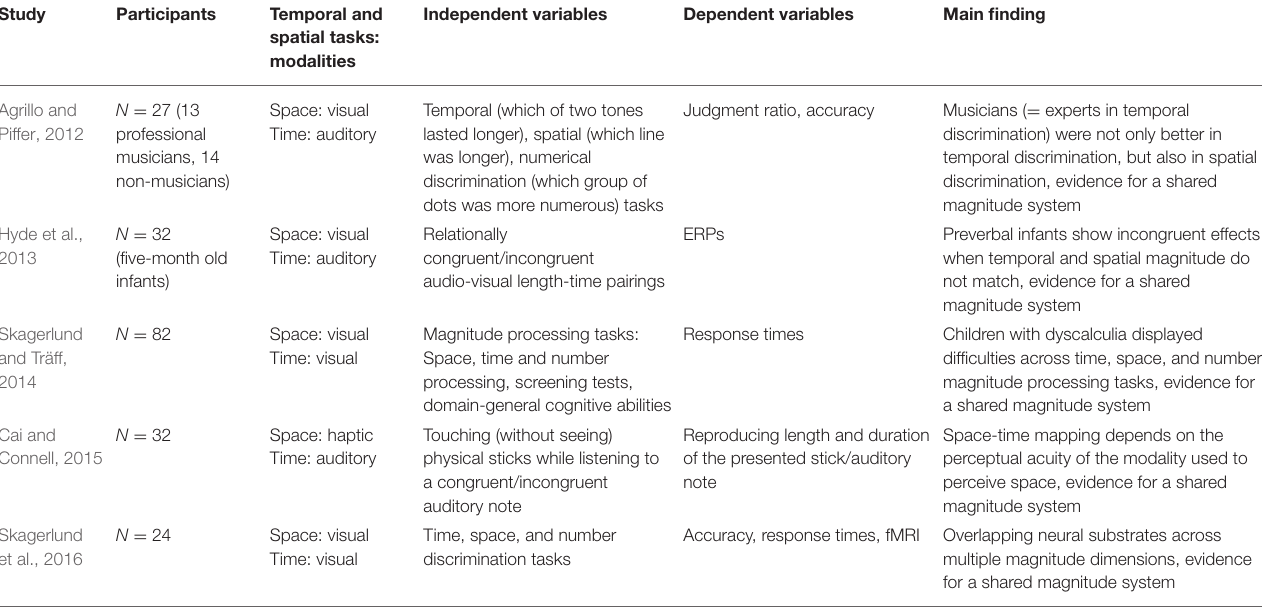
TABLE 2 | Studies supporting the theory of magnitude, and therefore a symmetric time-space